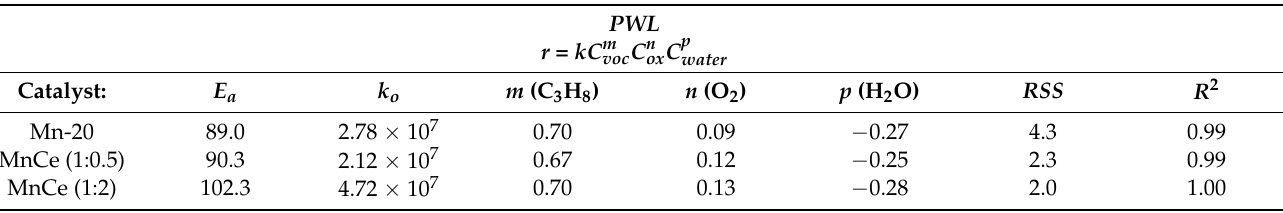
Table 6. Kinetics parameters based on power–law model. PWL